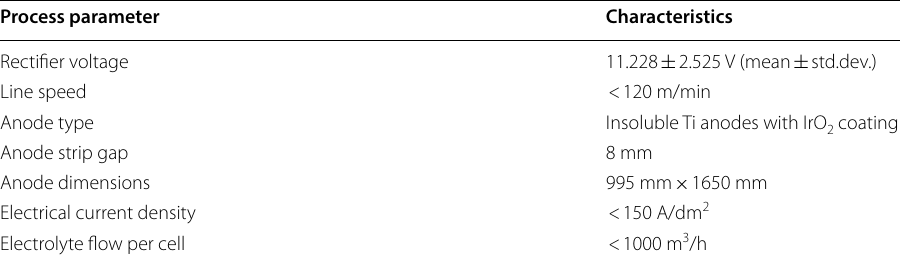
Table 1 General process parameters in the galvanizing unit, described previously in [24,